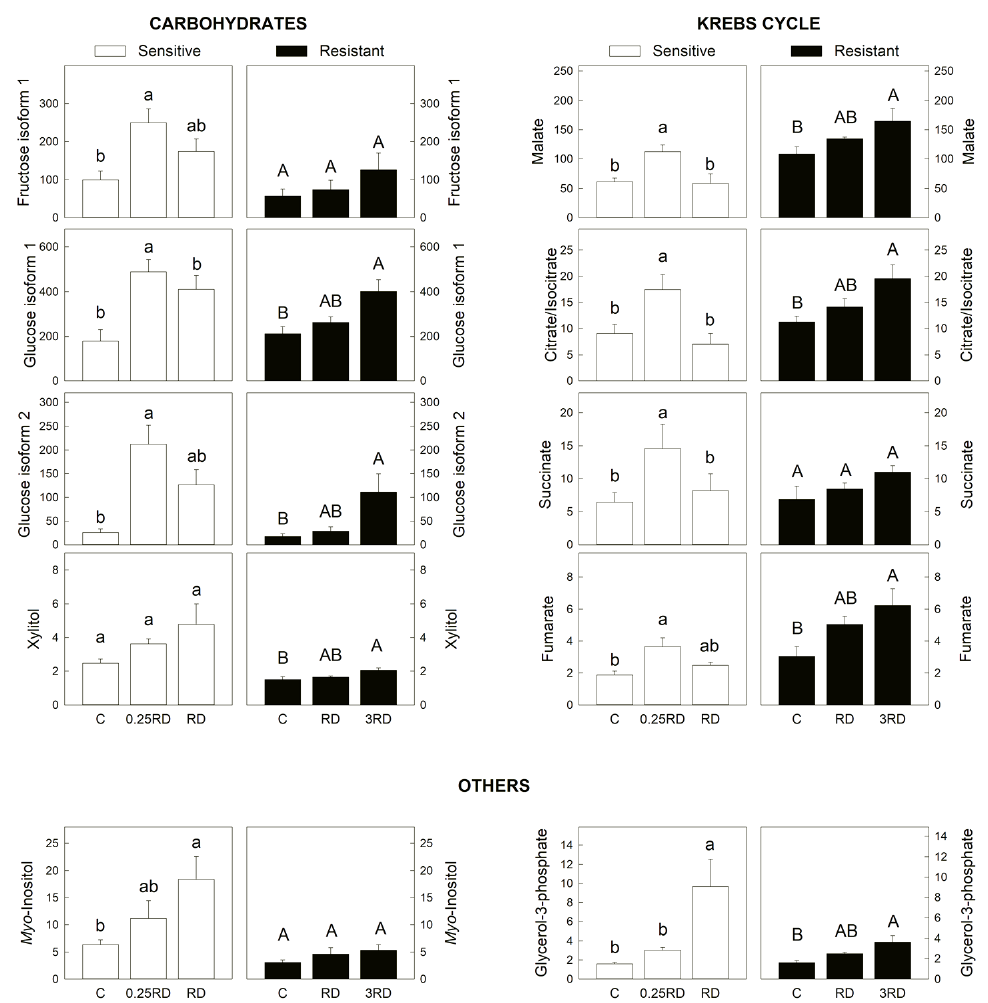
Figure 5. Selected primary metabolites detected by GC–MS in glyphosate-sensitive (GS) and resistant (GR) Amaranthus palmeri plants. Y-axis: normalized peak intensity: carbohydrates, Krebs cycle intermediates and others. Plants were not treated (control, C) or treated with glyphosate at two doses. The GS population was treated with 0.25× or 1× the field recommended dose (RD); the GR population was treated with 1× and 3× RD; mean ± SE (n = 4–6). Different letters within each population indicate significant differences between treatments ( p -value ≤ 0.05, Tukey).